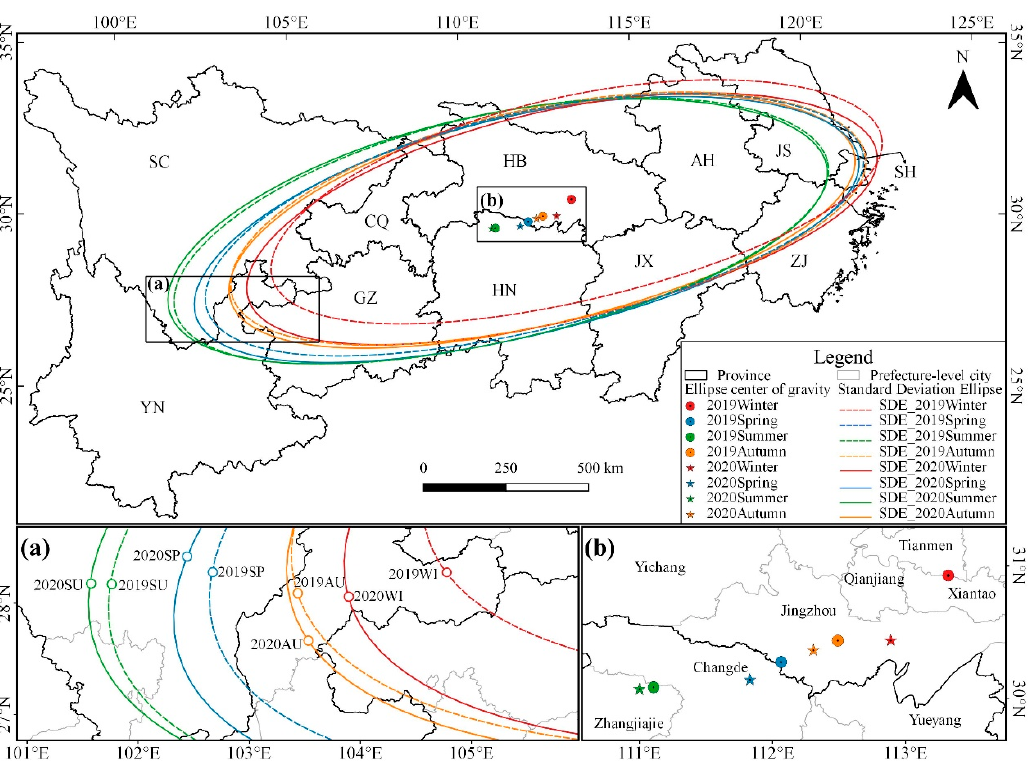
Figure 4. The distribution of standard deviation ellipse of NO 2 VCD in YREB. ( a ) More details on SDE. ( b ) The center of gravity .